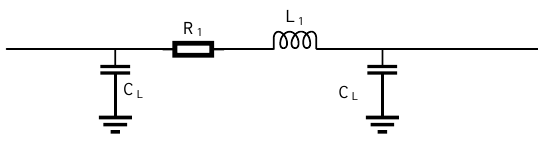
Figure 6. Equivalent circuit of overhead line.